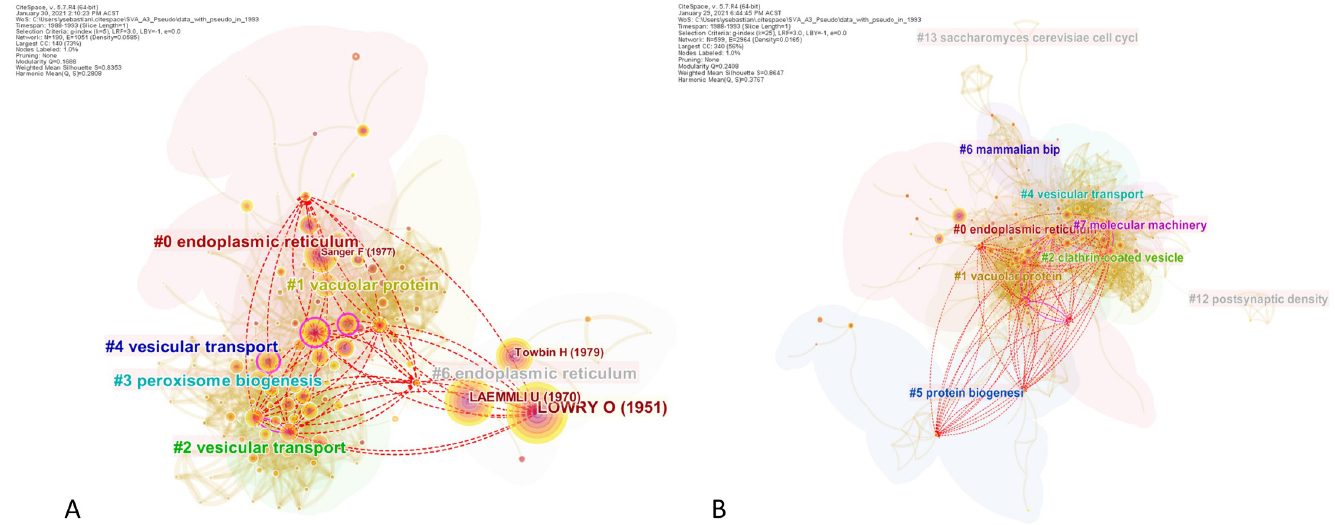
Fig 8. Visualizing the effects of increased scaling factors. Increasing the scaling factor of co-citation network in Case 3 (1988–1993) enriches the intellectual representation of the network and broadens the coverage of a pseudopaper’s novel links. (A) depicts the novel links added by Ps ( S 3,1 � S 3,2 ) ( k = 5). (B) shows the novel links added by the same pseudopaper for k =